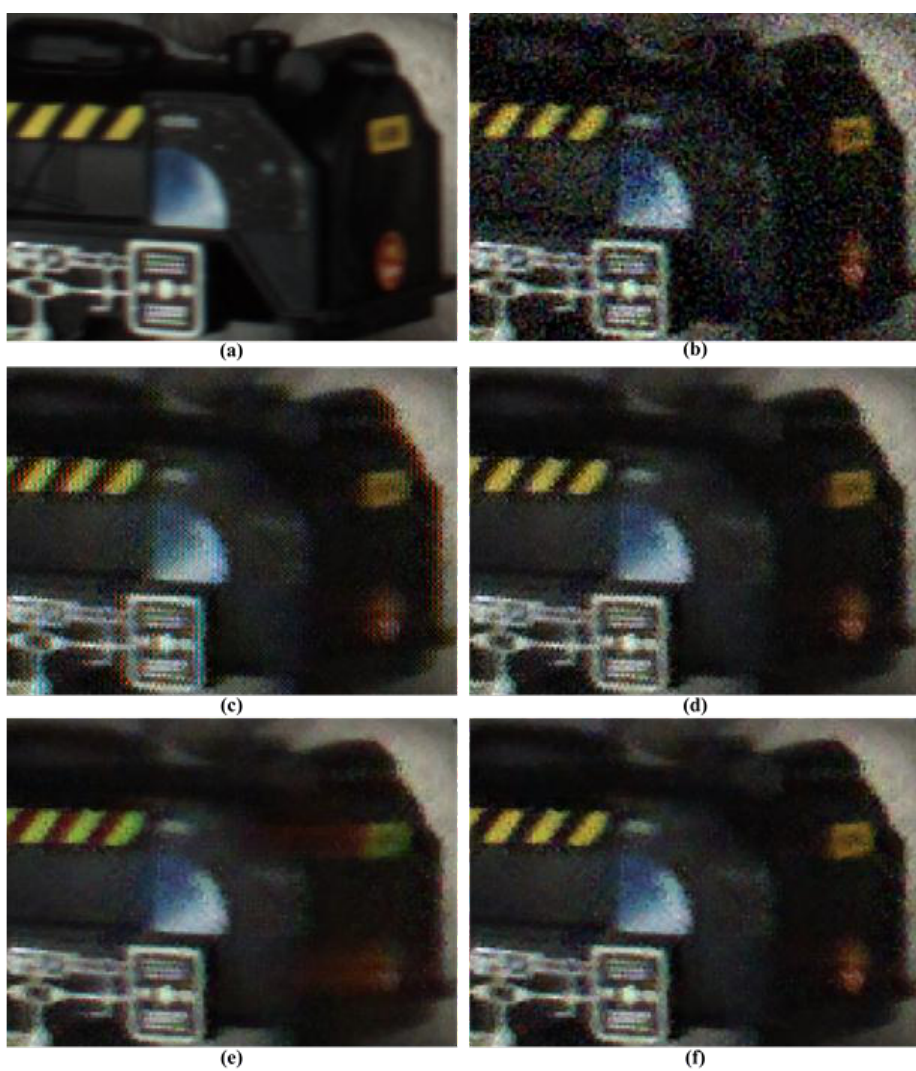
Figure 11. Partially magnified the Moving train sequence. ( a ) Original image; ( b ) Color demosaiced image obtained by [15] for noisy image with σ = 10 of Bayer pattern; ( c ) Denoised image by method [31] with demosaicing of [15]; ( d ) Denoised image by method [9] with demosaicing of [15]; ( e ) Denoised image by method [32]; ( f ) Denoised image by proposed method with demosaicing of [15].